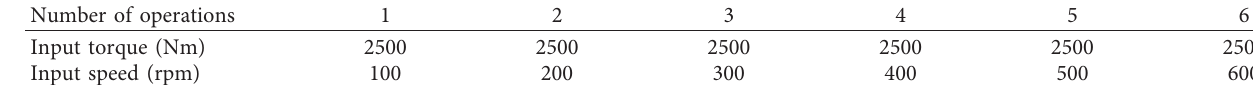
Table 3: Operating conditions.